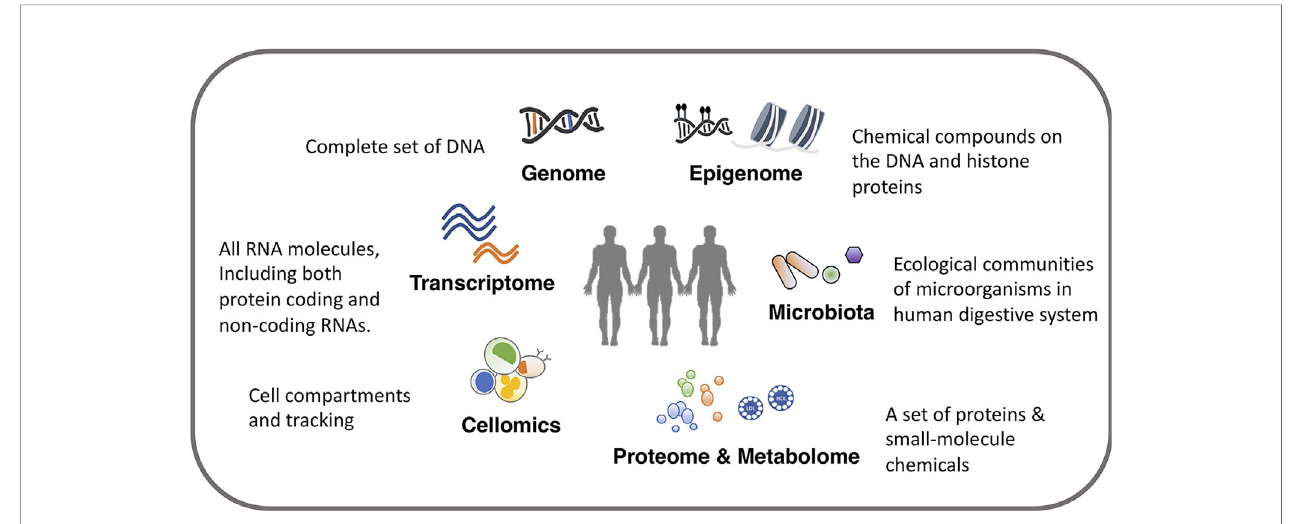
FIGURE 1 | Overview of omics